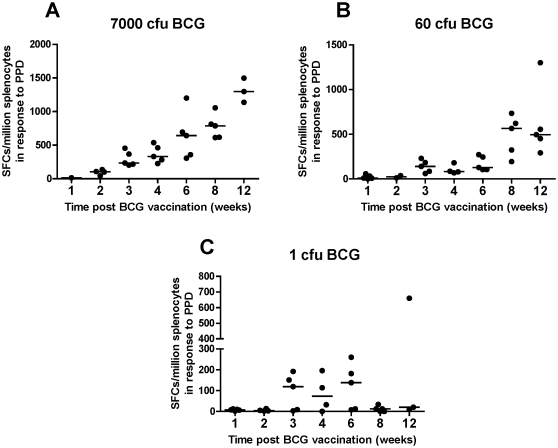
Splenic IFN-γ responses to PPD up to 12 weeks post BCG immunization.In (a) high dose group (7000 CFU id); (b) mid dose group (60 CFU id) and (c) low dose group (1 CFU id). Datasets include individual data points for each mouse; the bars represent the median value per group. Results expressed as SFC/million splenocytes.